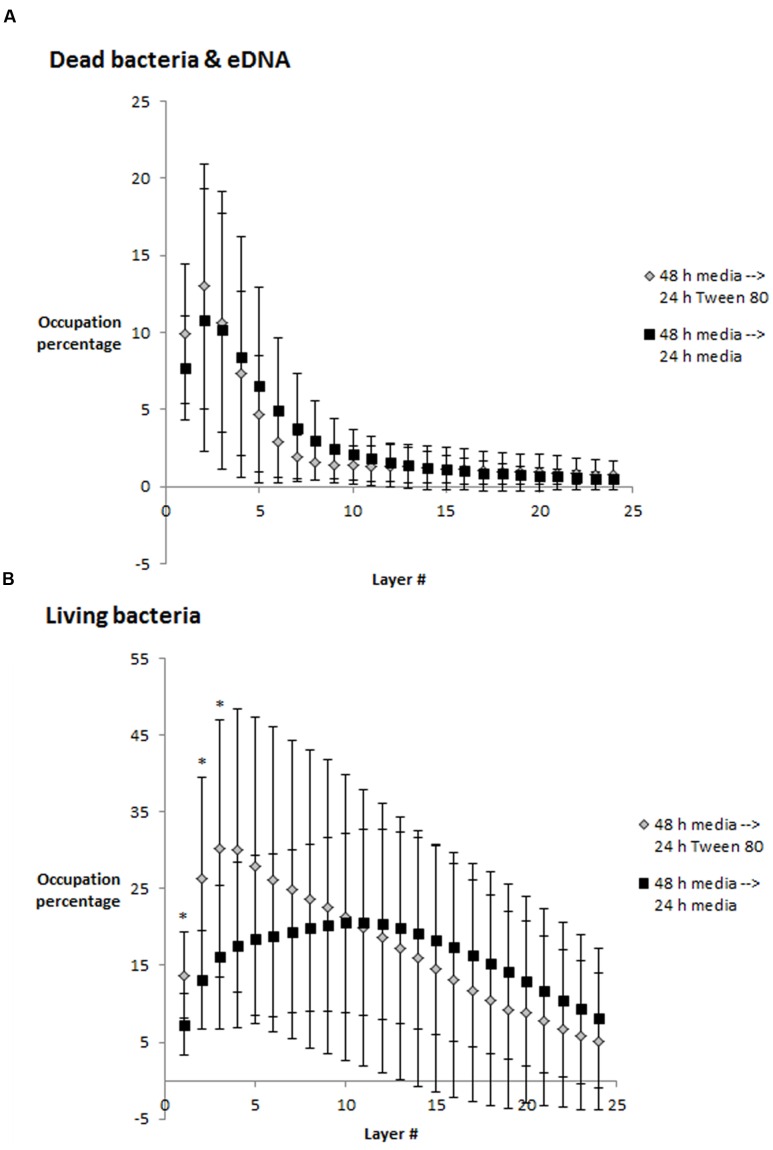
Occupied area (in percentage) per layer in z-stacks from confocal laser scanning microscopy images. (A) Dead bacteria and eDNA, (B) Living bacteria. Error bars show standard deviation of the mean (n = 10). Statistical significance (p < 0.05) is marked by ∗. Each layer corresponds to 0.53 μm.